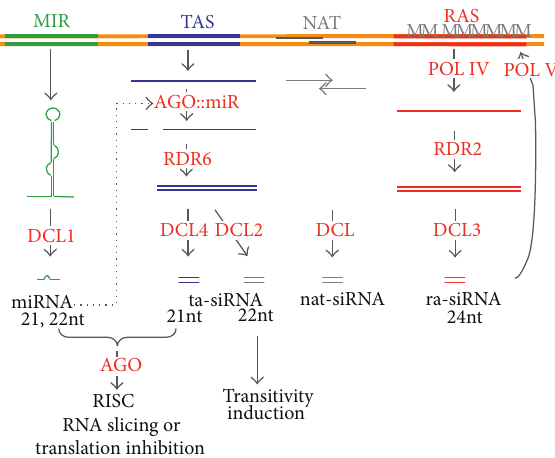
F 1: Posttranscriptional and transcriptional gene silencing pathways. Pri-miRNAs consist of a bulged hairpin �anked